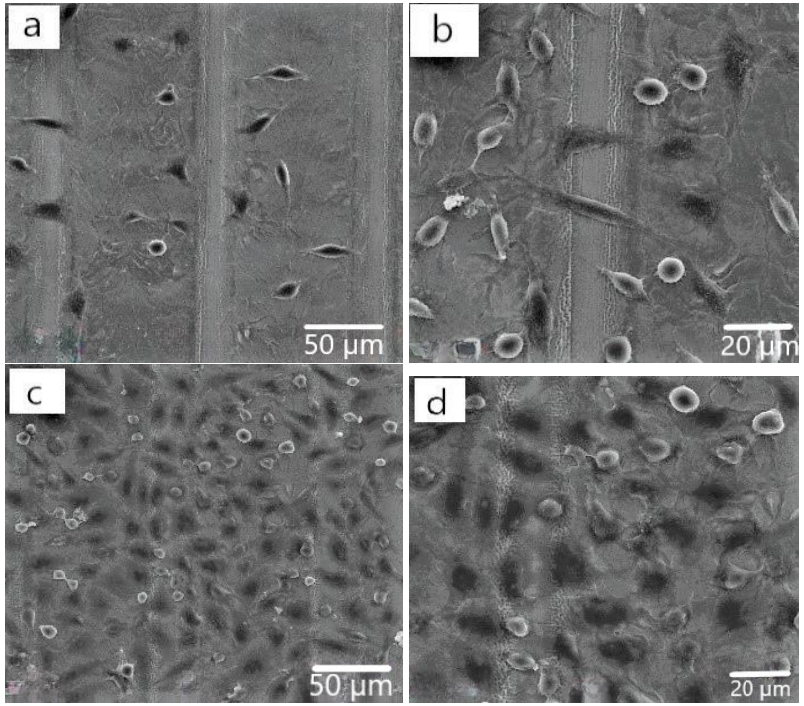
Figure 9. SEM images of laser-processed 316L commercial sample after growth test ( a ) 1 day, × 500 and ( b ) 1 day, × 1000, ( c ) 3 days, × 500, ( d ) 3 days, × 1000.